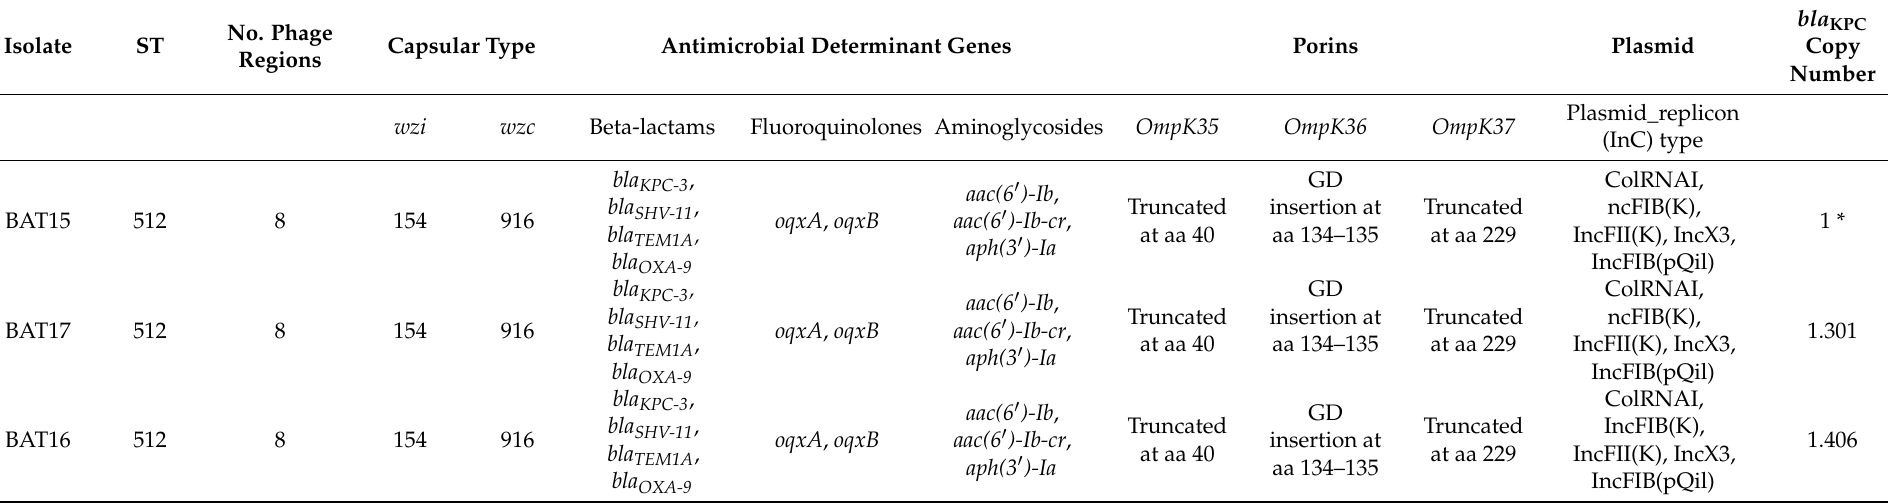
Table 2. Genotypic traits of KPC-Kp strains included in this